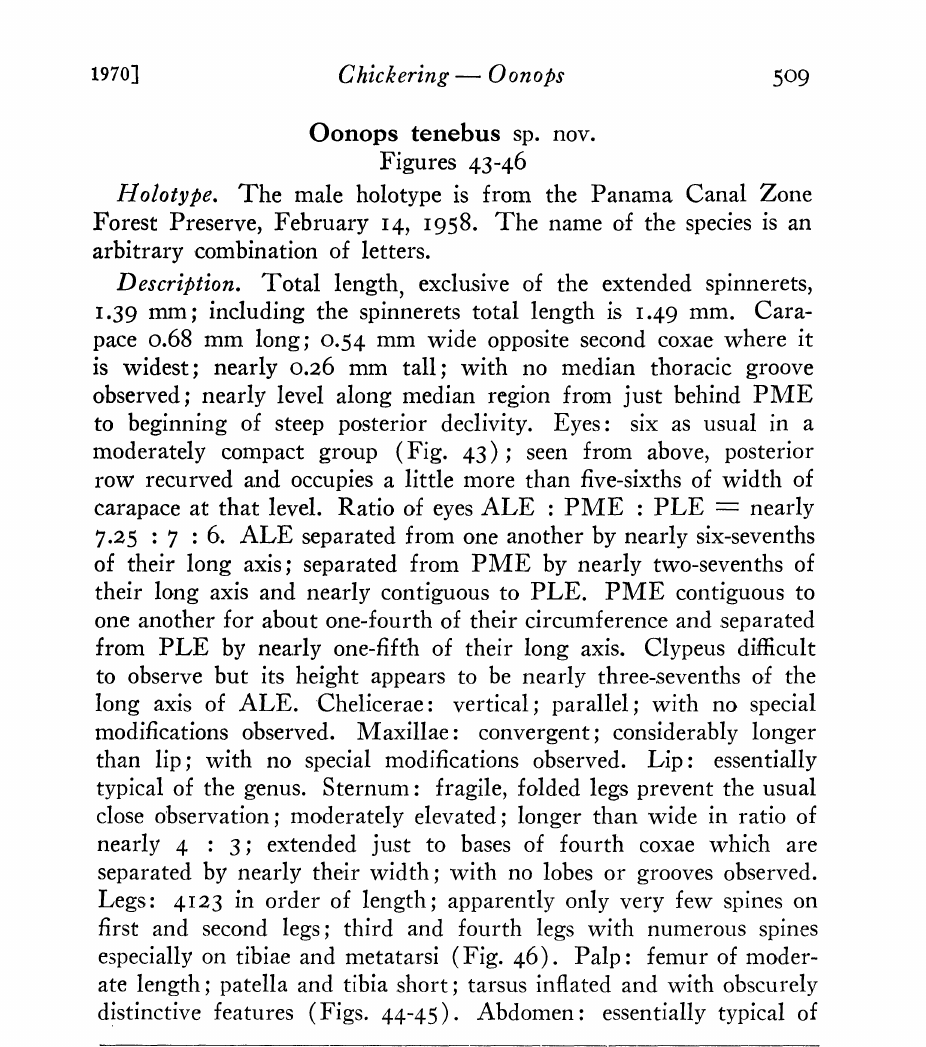
Figs. 40-42. Oonols sicorius sp. nov. Fig. 40. Eyes of male holotype from above. Figs. 41-42. Left palp of male holotype; nearly dorsal and nearly retrolateral views, respectively. Figs. 43-46. Oonops tenebus sp. nov. Fig. 43. Eyes of male holotype from above. Fig. 44. Left palp of male holotype; prolateral view. Fig. 45. Left palpal tarsus of male holotype; nearly ventral view. Fig. 46. Right fourth tibia of holotype; dorsal view. Figs. 47-51. Oonops estus sp. nov. Figs. 47-48. Carapace of male para- type; from above and left lateral side, respectively. Fig. 49. Eyes of holo- type from above. Fig. 50. Left palp of male holotype; prolateral view. Fig. 51. Epigynal area of described female paratype from